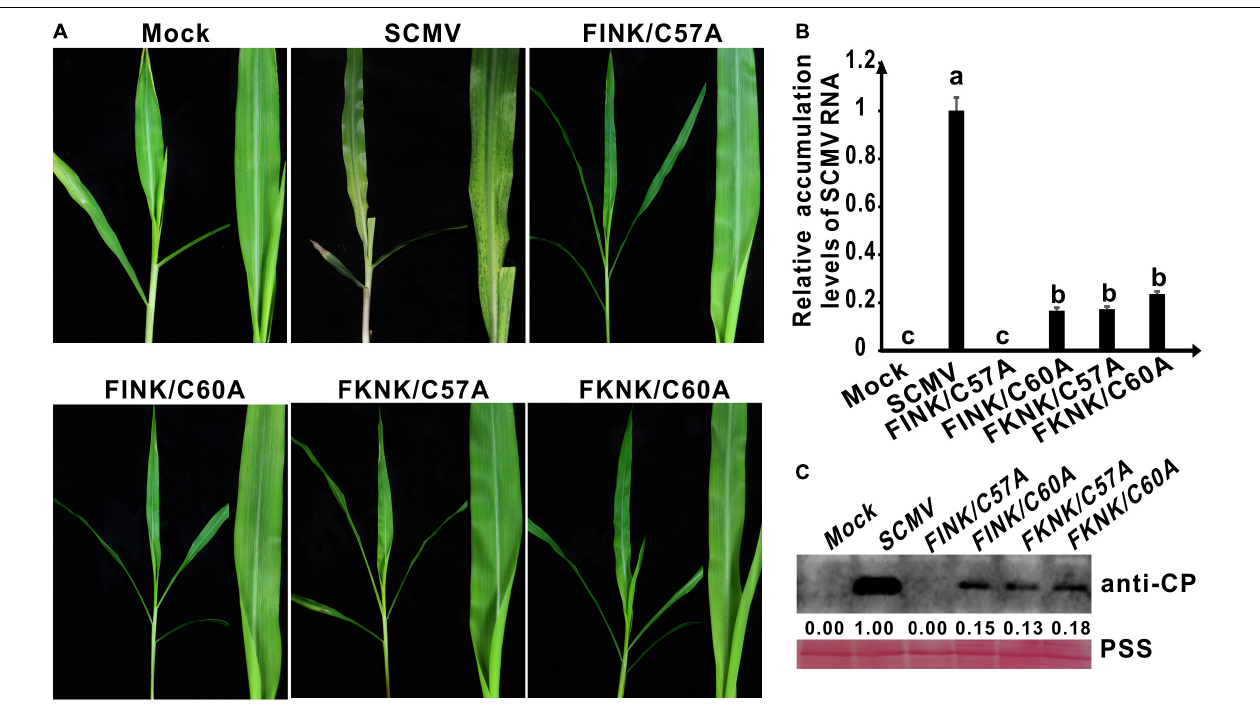
FIGURE 3 | Symptoms and accumulation levels of SCMV double-mutants in maize plants. (A) Symptoms of wild-type SCMV and its double-mutants in maize plants at 10 dpi. Mock, the maize plants inoculated with the empty vector pCB301-Rz. SCMV, the maize plants infected with wild-type SCMV. FINK/C60A, the conserved C 60 was mutated to A residues and R 184 was mutated to I residues in SCMV HC-Pro. FKNK/C57A, the conserved C 57 were mutated to A residues and R 184 were mutated to K residues in SCMV HC-Pro. FKNK/C60A, the conserved C 60 was mutated to A residues and R 184 were mutated to K residues in SCMV HC-Pro. (B) The wild-type and mutant SCMV RNA accumulation levels in the upper leaves of maize plants at 10 dpi. (C) Western blotting analysis of the wild type and mutant SCMV accumulation levels in the upper leaves of maize plants at 10 dpi. The ponceau S staining (PSS) shows sample loadings. Band intensities were measured using the ImageJ software. Numbers indicated the accumulation levels of SCMV CP normalized to PSS staining. The experiments were repeated thrice independently. The statistical analyses as